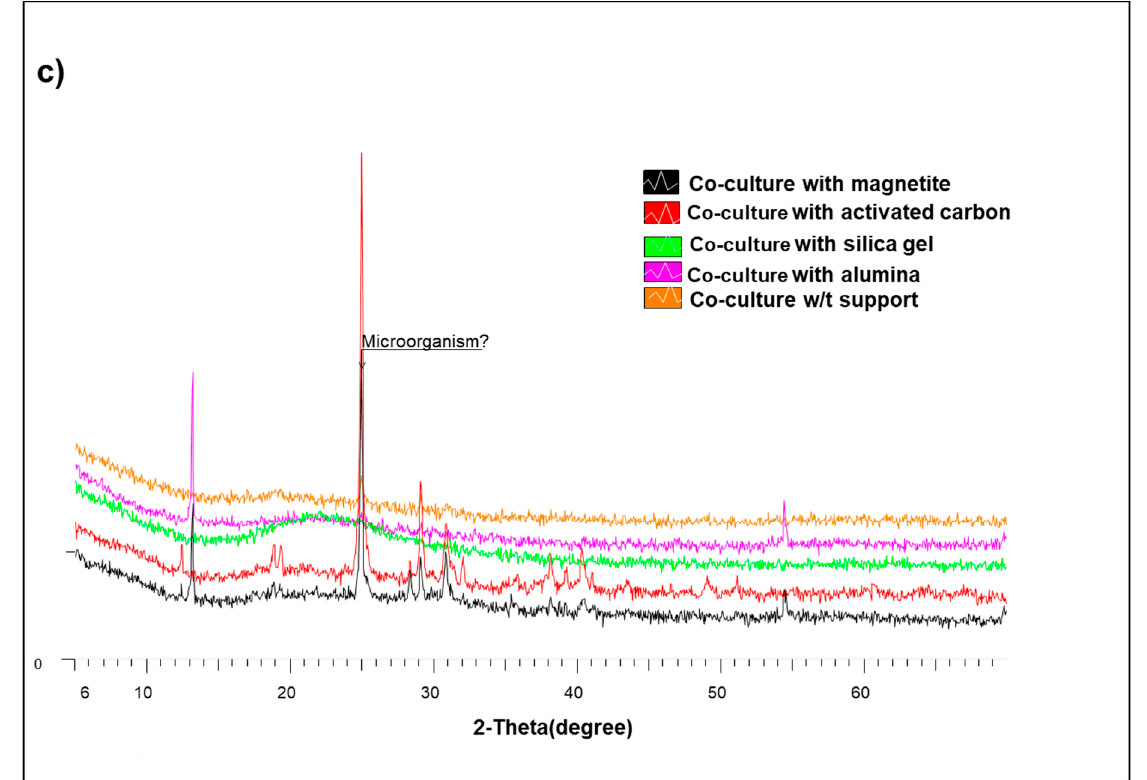
Figure 2. Powder XRD patterns: ( a ) AC before dark fermentation; ( b ) AC after dark fermentation; and ( c ) all supports after dark fermentation.